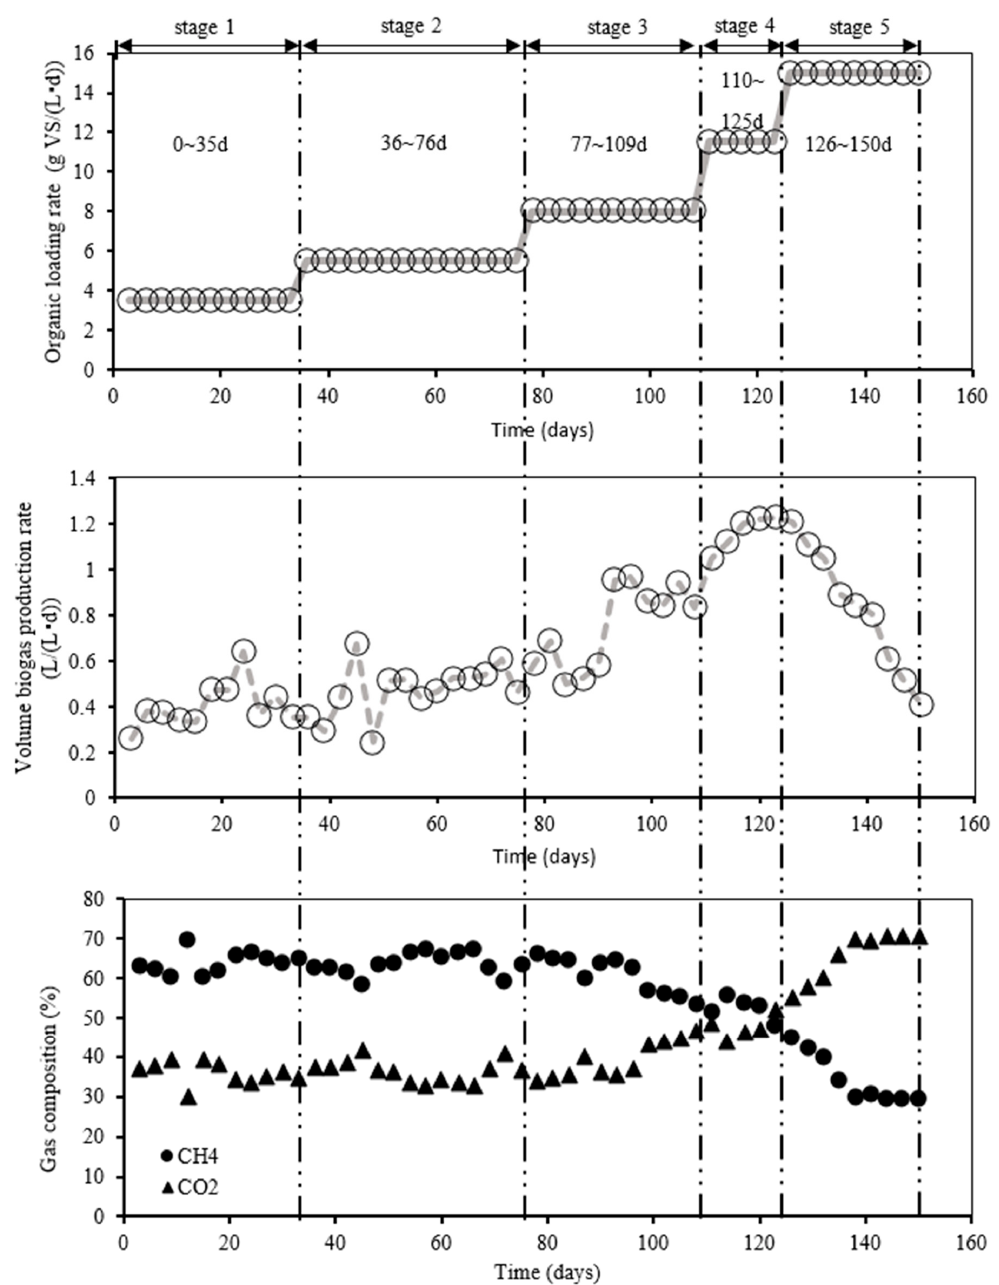
ff ect of OLR on the volumetric biogas production rate and gas Figure 2. Effect of OLR on the volumetric biogas production rate and gas composition. 201 Figure 2. E